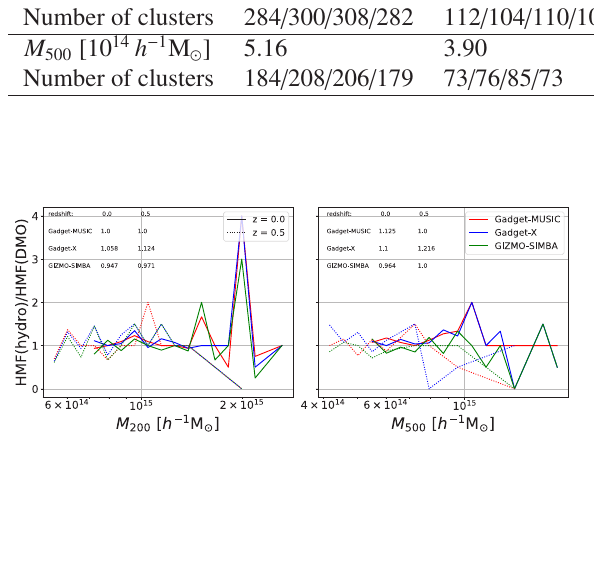
Table 1. The mass-complete samples at di ff erent redshifts. The second row shows the mass completeness thresholds for M 200 with the numbers of clusters above that threshold in MDPL2, G adget -MUSIC, G adget -X and G izmo -SIMBA, respectively. Similar results at M 500 are at bottom. Redshift